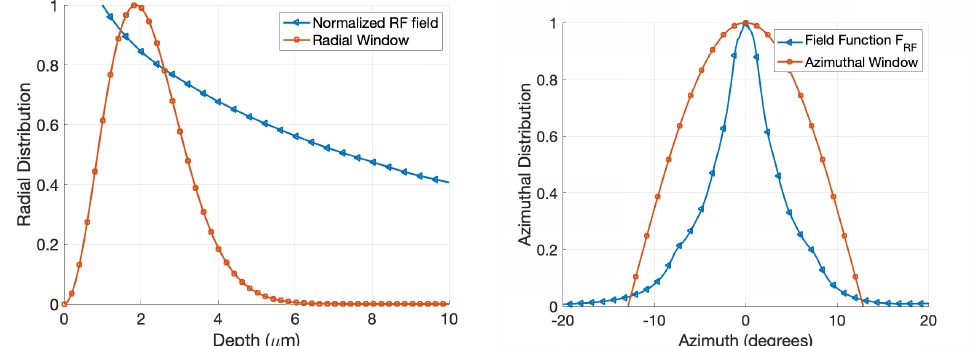
Figure 6. Simulated RF field strength and the radial window function vs. the depth ( left ). Simulated normalized RF field strength F RF ( w 0 ,0, φ ) evaluated at the optical WGM depth w 0 ≈ 2 µ m, and the azimuthal window function cos7 φ ( right